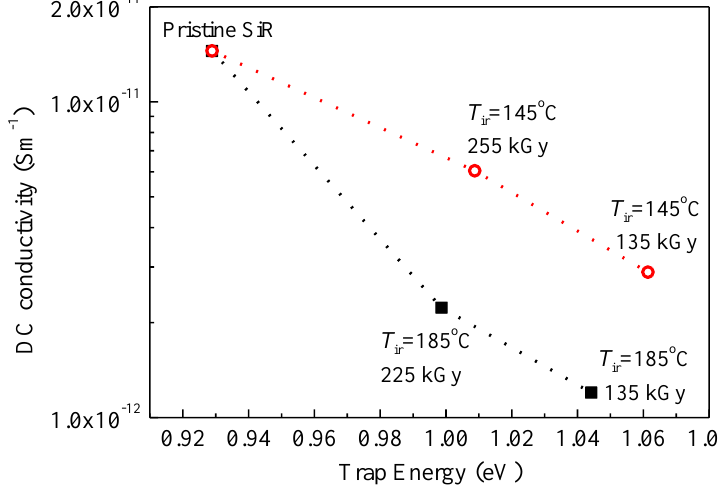
Figure 14. DC conductivity of SiR samples degraded by gamma irradiation at two different temperatures as a function of trap energy.